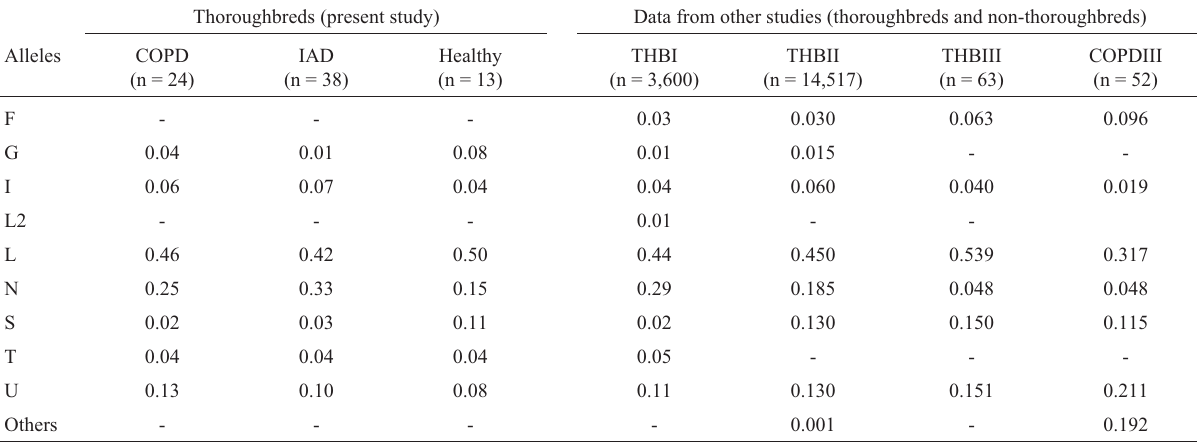
Table 1 - Proteinase inhibitor (PI) allele frequencies in thoroughbred horses. Thoroughbreds (present study)